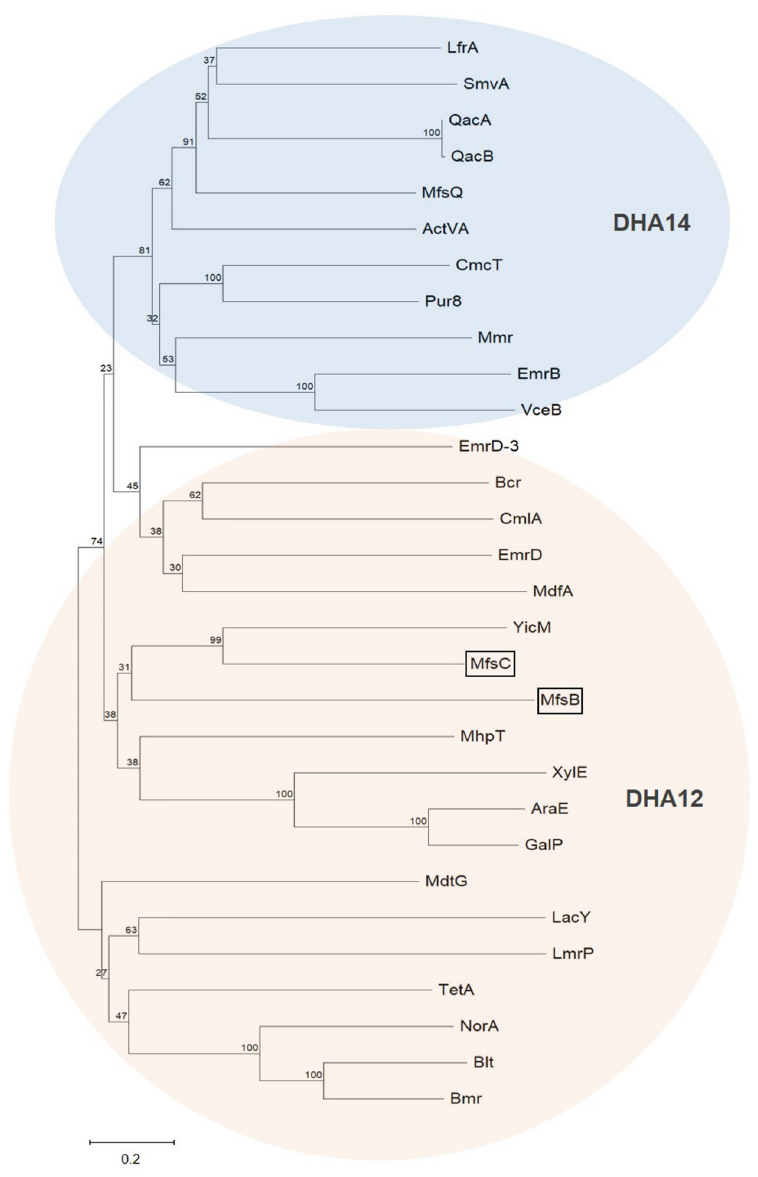
Fig 1. Phylogenetic analysis of S . maltophilia MfsC. Phylogenetic tree was constructed by the neighbor-joining method with 500 bootstrap replicates using MEGA11 software. Amino acid sequences of known MFS belonging to DHA14 and DHA12 from various bacteria were retrieved from the UniProt (https://www.uniprot.org). DHA14; ActVA (Q53903), CmcT (Q04733), EmrB (P0AEJ0), LfrA (A0R5K5), MfsQ (B2FTN0), Mmr (P11545), Pur8 (P42670), QacA (Q1XG09), QacB (Q7WUJ5), SmvA (P37594), VceB (O51919). DHA12; AraE (P0AE24), Bcr (P28246), Blt (P39843), Bmr (P33449), CmlA (Q83V15), EmrD (P31442), EmrD-3 (C3LUT7), GalP (P0AEP1), LacY (P02920), LmrP (Q48658), MdfA (P0AEY8), MdtG (P25744), MhpT (P77589), NorA (P0A0J7), TetA (P02981), XylE (P0AGF4), YicM (J7R7Q1).